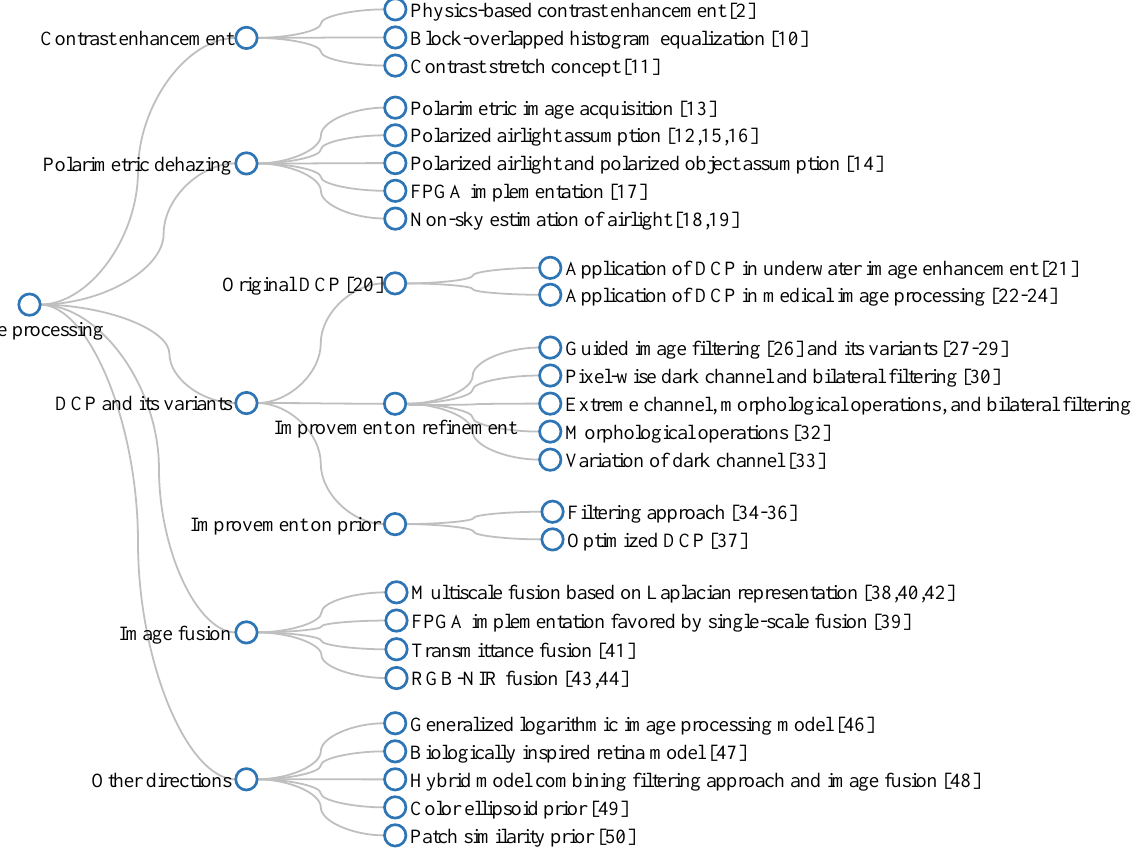
Figure 8. Branching diagram summarizing image-processing-based dehazing